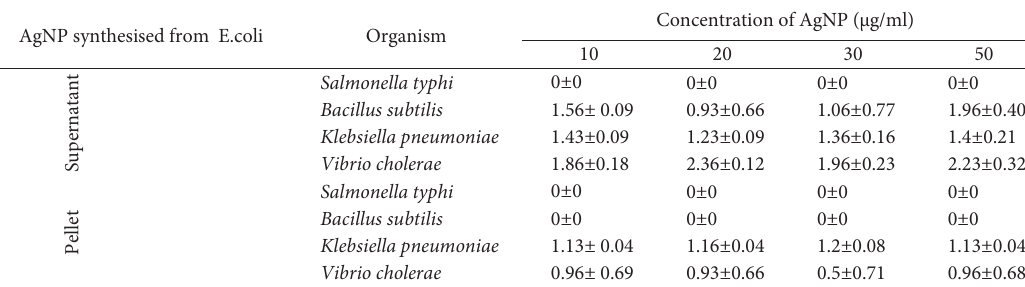
Table 1. Determination of crystalline size of silver nanoparticles using Debye Scherrer’s equation. Table 2. Antimicrobial activity of silver nanoparticle synthesised from Escherichia coli* * Values expressed as Mean± S.D * AgNP synthesised from E.coli